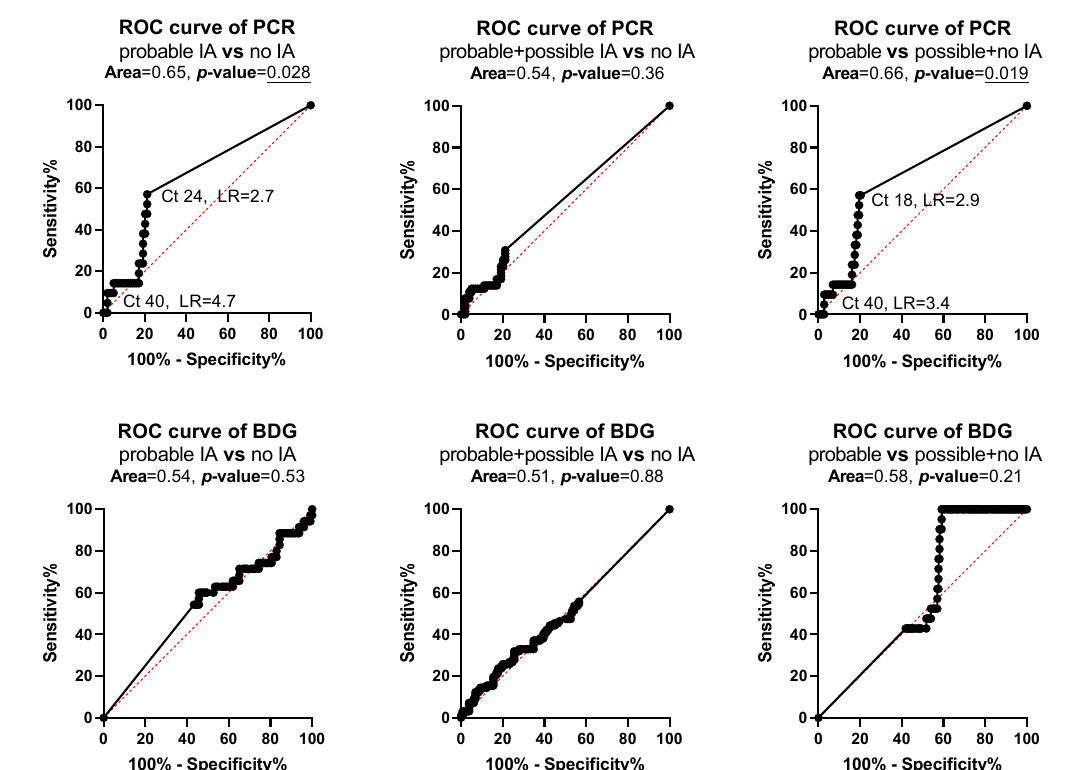
Figure 3. Receiver operating characteristic (ROC) curve analysis for polymerase chain reaction (PCR) and 1,3- β -D glucan (BDG) for patients with probable, possible and no invasive aspergillosis (IA). p values <0.05 are underlined indicating the test discriminate patients to different classifications of IA.